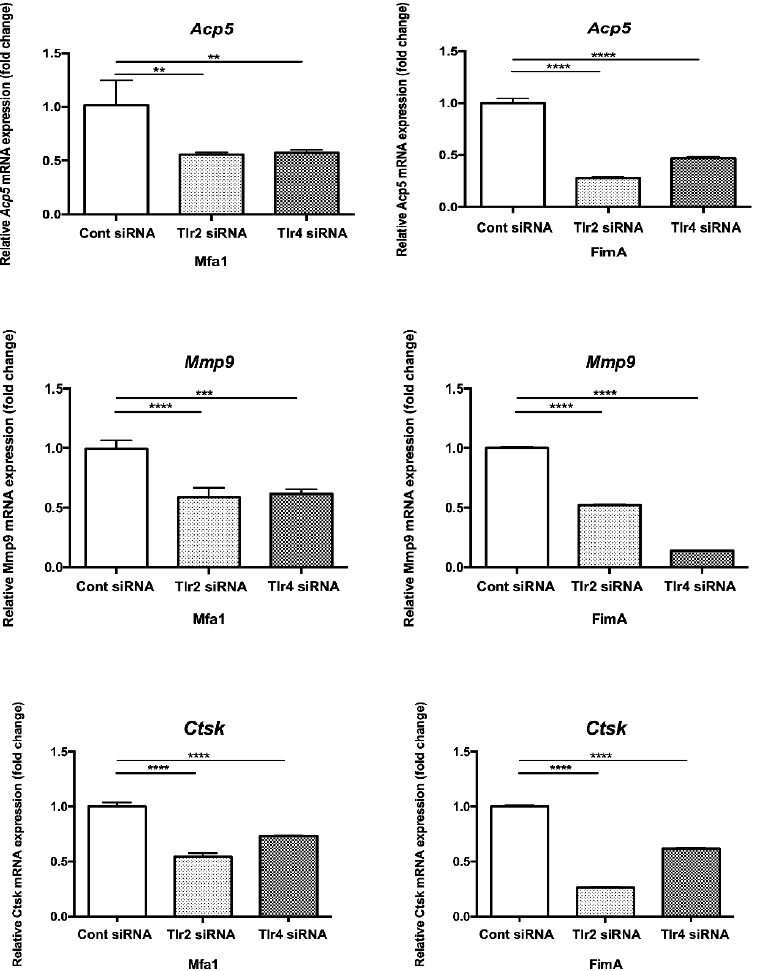
Figure 6. Suppression of TLR2 or TLR4 expression attenuates induction of osteoclast differentiation marker genes by Mfa1. Tlr2 siRNA and Tlr4 siRNA-transfected cells were prestimulated with RANKL for 24 h and then cultured for 48 h in the presence of 1 µ g/mL Mfa1 or FimA fimbriae. mRNA levels were then examined by qPCR. Values are expressed as fold changes. Differences between groups were analyzed by ANOVA and Tukey’s test. Data represent the mean ± SD ( n = 3). ** p < 0.01, *** p < 0.001, **** p < 0.0001.